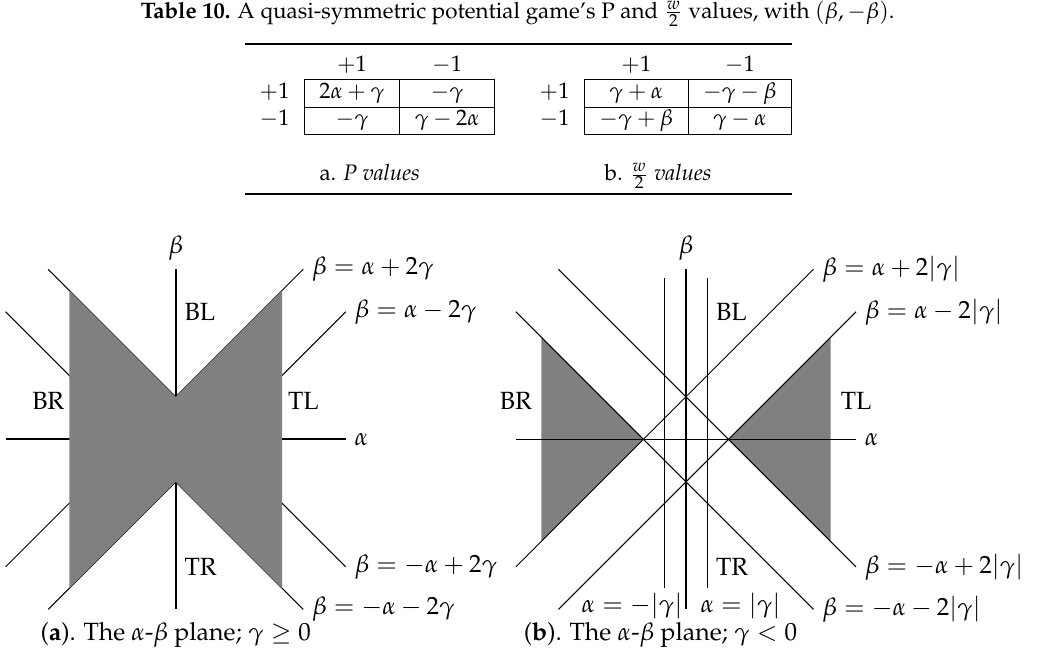
Table 10. A quasi-symmetric potential game’s P and w